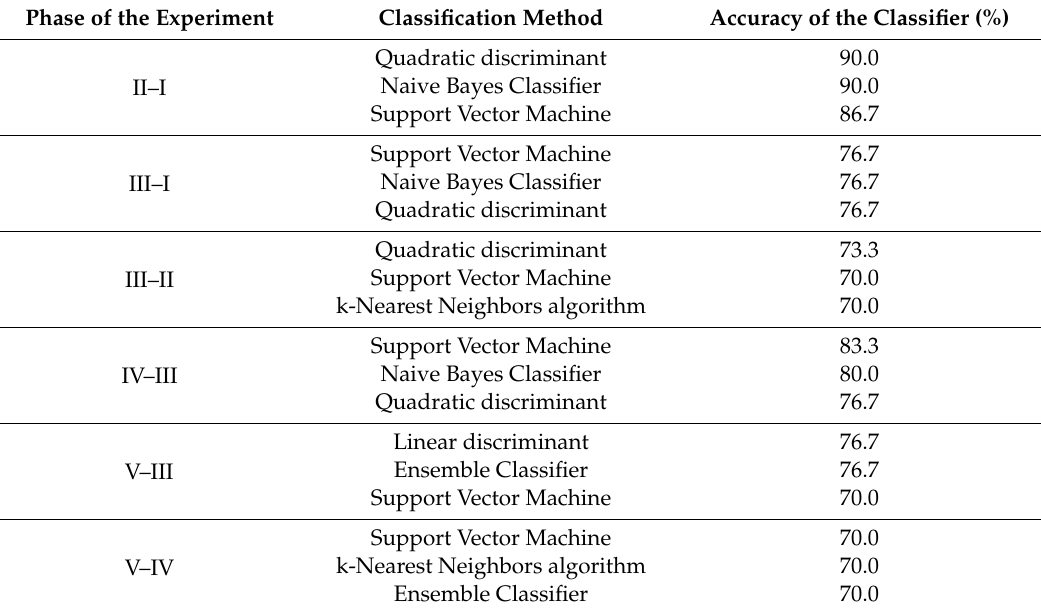
Table 3. Results of classification of water supply system operation states.